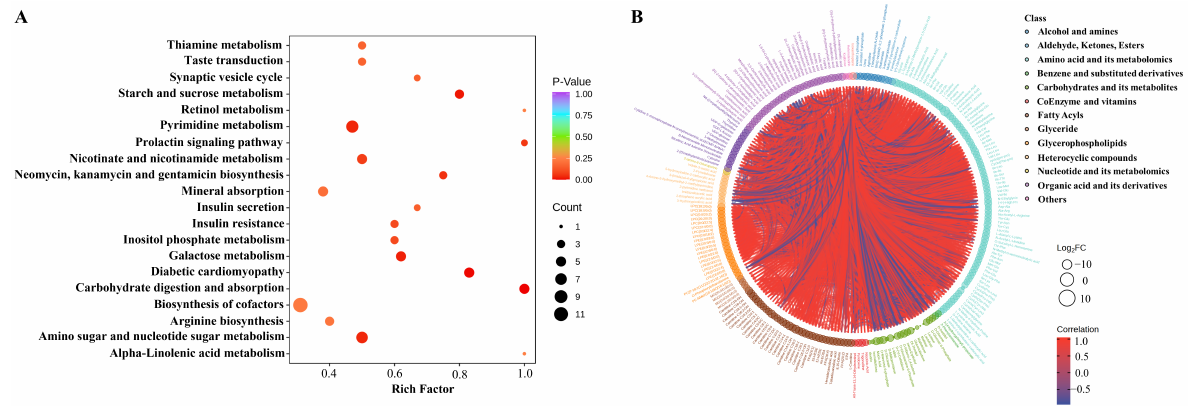
Figure 4. KEGG enrichment and Pearson correlation analysis of differential metabolites between SG and FG meat. ( A ) KEGG annotation and enrichment analysis of differential metabolites. ( B ) The chord diagram of differential metabolites by Pearson correlation